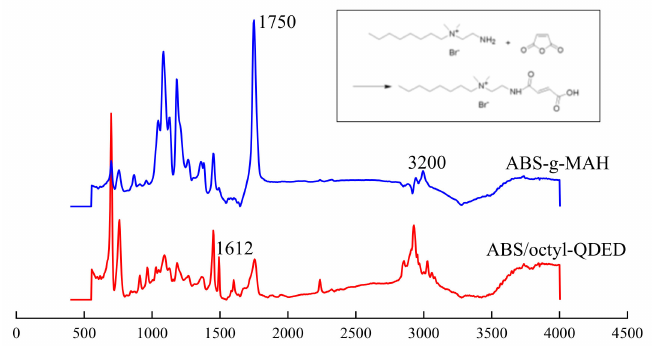
Figure 4. FT-IR spectra of ABS-g-MAH and ABS /